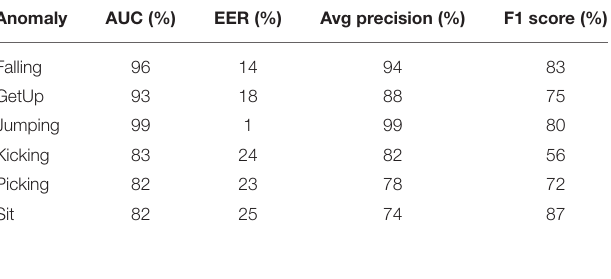
TABLE 3 | Quantitative analysis of proposed network in terms of Area Under Curve (AUC), Equal Error Rate (EER), average precision, and F1 score. Anomaly